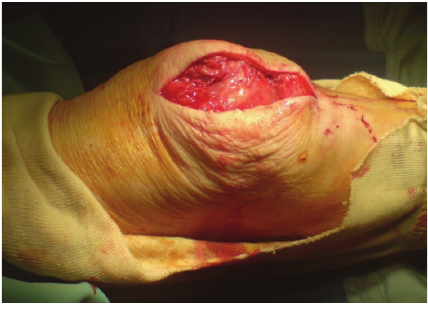
Figure 4: Postreduction